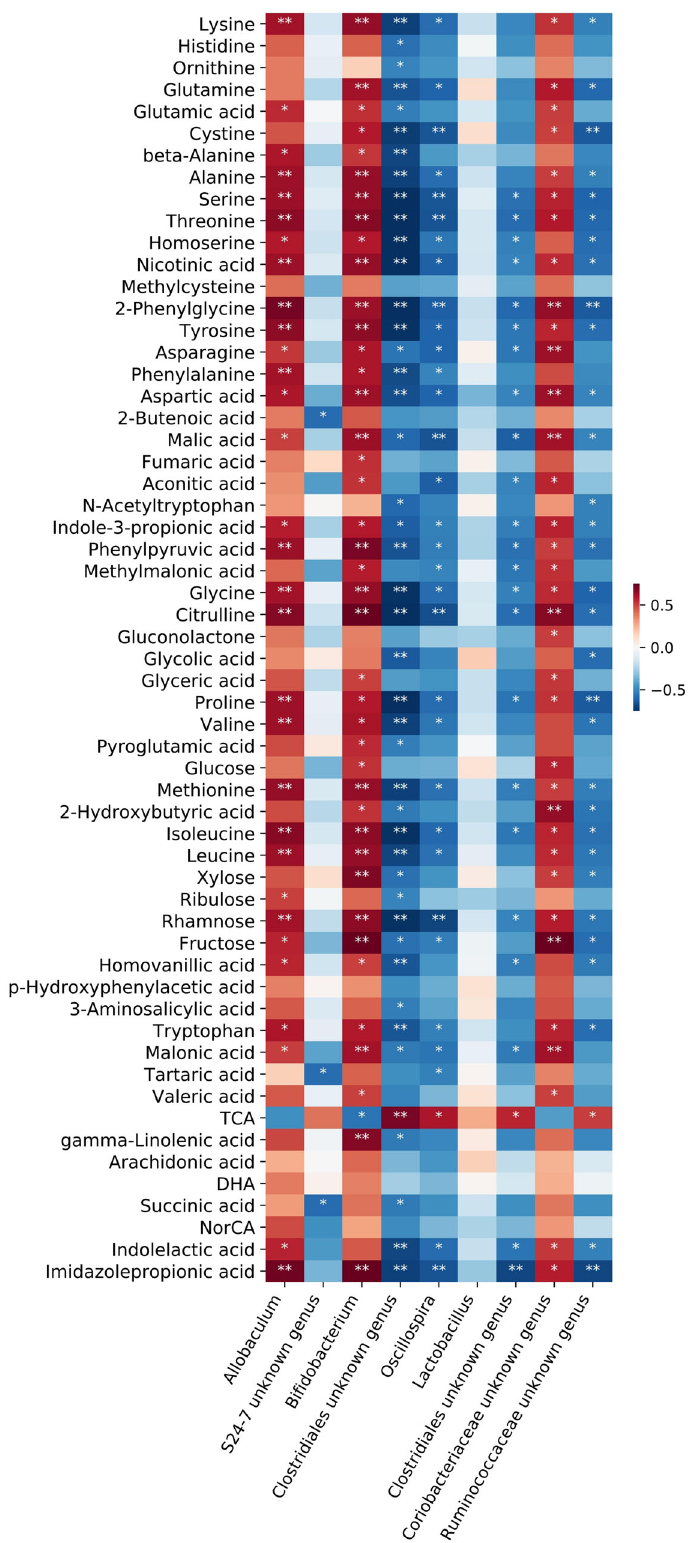
Fig. 6 Correlation analysis of targeted metabolomics and 16S rRNA sequencing. Color coding scale indicates the correlation analysis value from heatmap, the deeper red or blue indicates higher correlation values. Grids in red indicate positive correlations, while grids in blue indicate negative correlations. * p < 0.05, ** p <